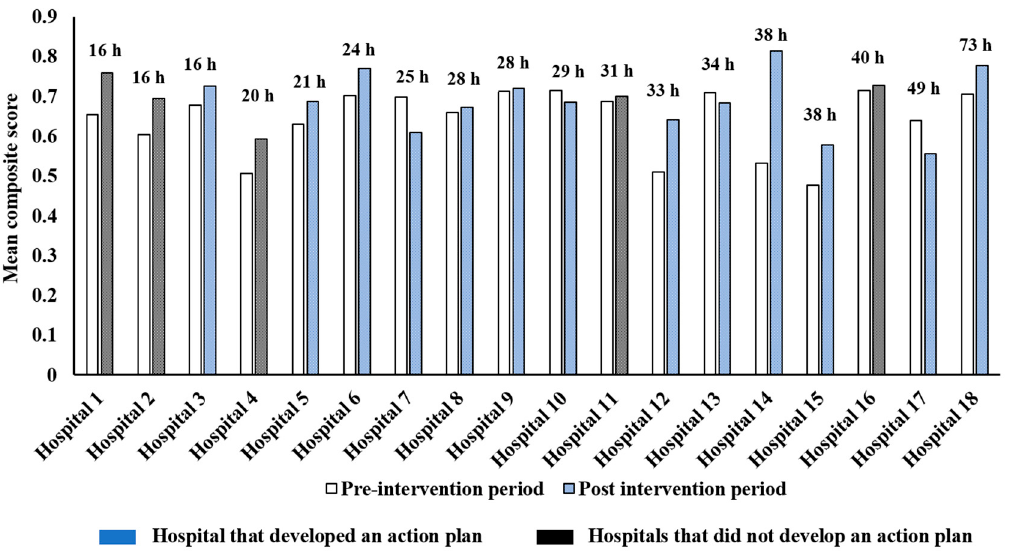
Figure 2. Change in mean composite score from <=8 acute stroke processes of care collected in all QLD hospitals participating in the multicomponent quality improvement program—Enhanced StrokeLink. Support provided by external facilitators to the respective hospitals during the multicomponent quality improvement program—Enhanced StrokeLink period is displayed in hours (i.e., h). Missing AuSCR data for one hospital.